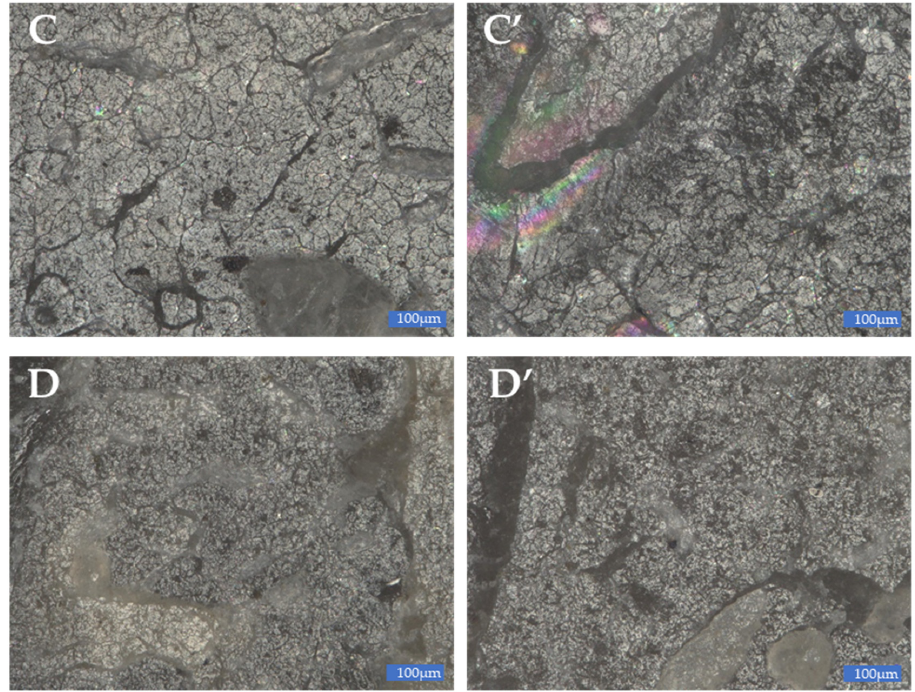
Figure 20. Optical microscope photos of composite fractures conditioned at room temperature (RT) and after conditioning in the weathering chamber (WCh): ( A )–2.5sedA RT, ( A’ )–2.5sedA WCh, ( B )–15sedA RT, ( B’ )–15sedA WCh, ( C )–2.5sedB RT, ( C’ )–2.5sedB WCh, ( D )–15sedB RT, ( D’ )–15sedB WCh.